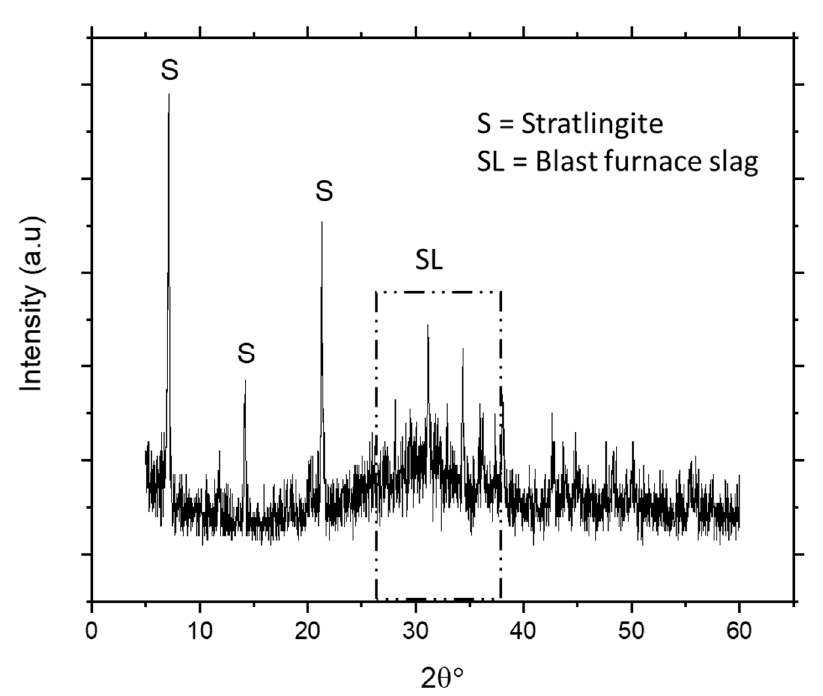
Figure 3. XRD of the alkali-activated powder (28 days of curing).